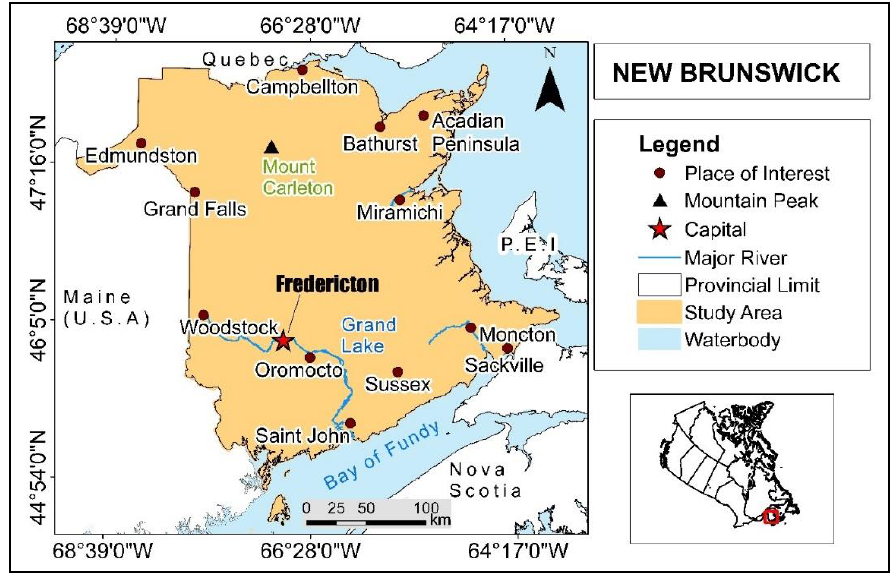
Figure 2. Location of study area.